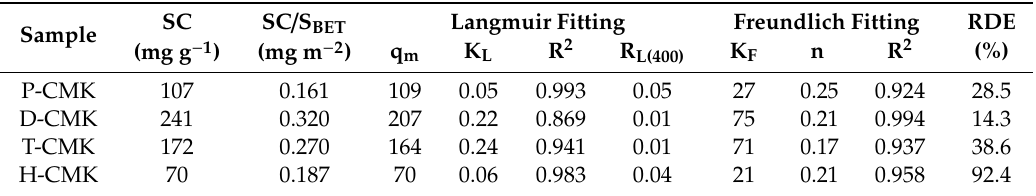
Table 3. Sorption capacities (SC) of DICL and parameters calculated from the Langmuir and Freundlich